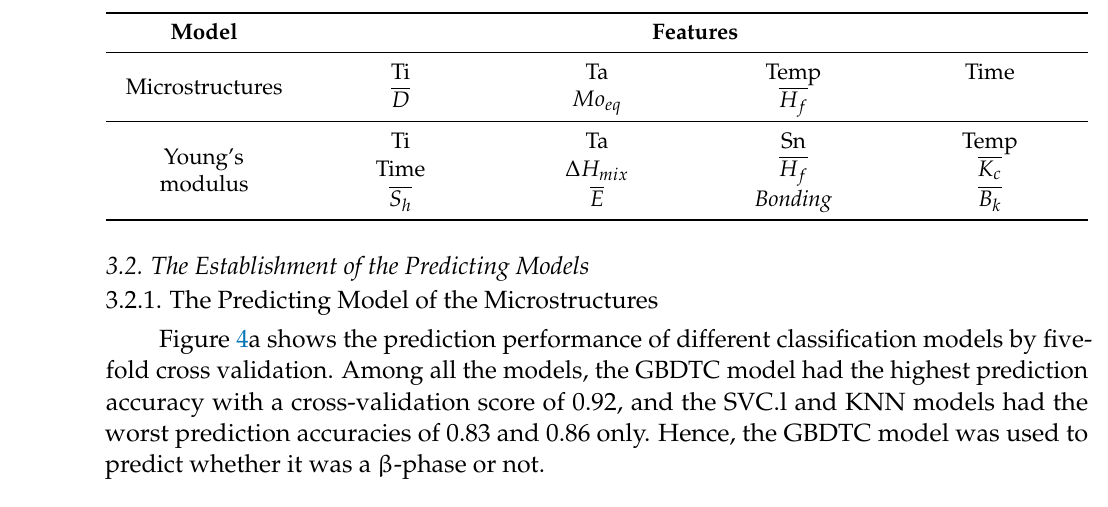
Figure 3. FSS feature selection results: ( a ) the microstructures dataset and ( b ) the Young ’ s modulus dataset. Table 2. The optimal combinations of features were obtained after feature selection, which produces the best performance of the model.